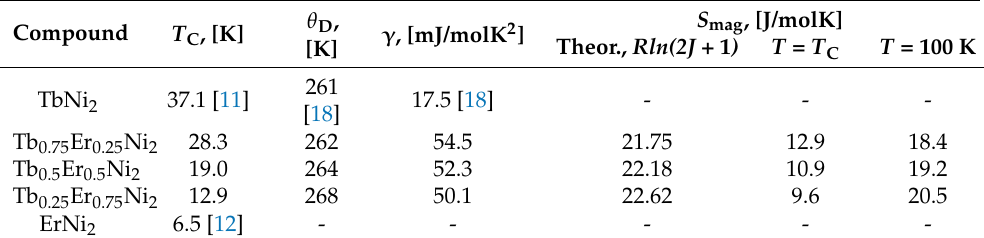
Table 1. Experimental results for the Tb 1 − x Er x Ni 2 intermetallic compounds obtained from heat capacity data: T C is a Curie temperature; θ D is a Debye temperature; γ is the Sommerfeld coefficient; S mag is magnetic entropy; maximum theoretically calculated at the T C temperature and at the temperature of 100